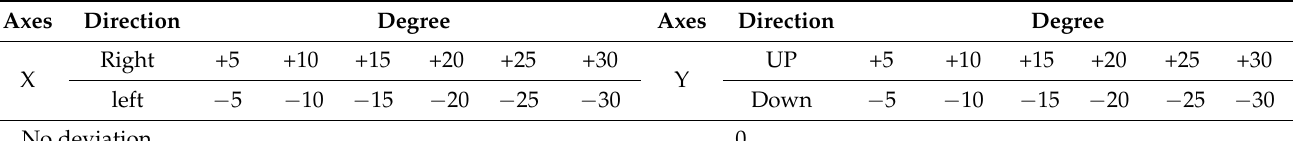
Table 4. The used degree in terms of axes and